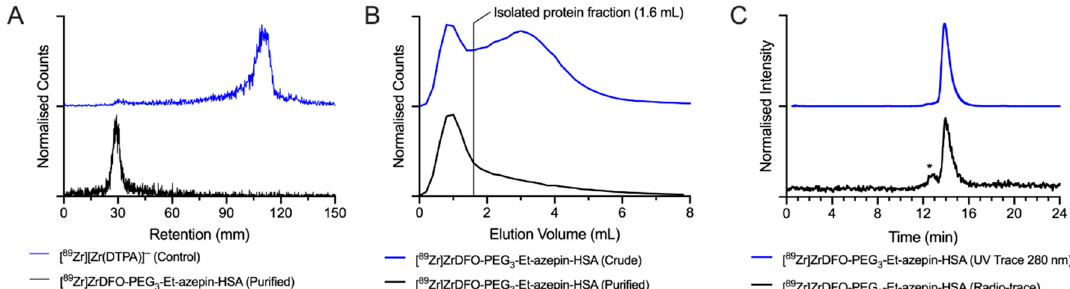
Figure 4. Radioactive chromatography depicting: ( A ) radio-ITLC chromatograms of purified (black) [ 89 Zr]ZrDFO-PEG 3 -Et-azepin-HSA (RCP > 95%) and control (blue) [ 89 Zr][Zr(DTPA)] − . ( B ) Analytical SEC (PD-10) elution profiles displaying crude (blue) and purified (black) samples of [ 89 Zr]ZrDFO-PEG 3 -Et-azepin-HSA. ( C ) Radioactive (black) and electronic absorption (blue) SEC gel-filtration HPLC chromatograms of the purified [ 89 Zr]ZrDFO-PEG 3 -Et-azepin-HSA (RCP > 90%). Note that (*) designates aggregated protein.